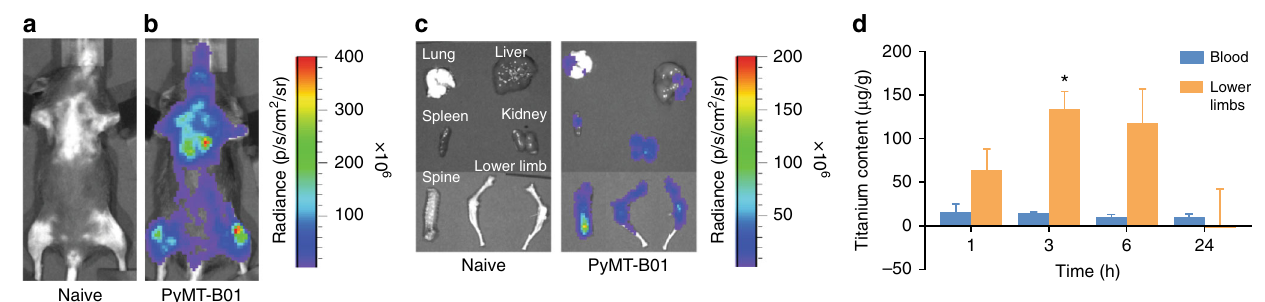
Fig. 5 Dissemination of metastatic breast cancer cells and biodistribution of TC in mice. a In vivo BLI non-tumour-bearing C57BL/6J mice. b In vivo BLI of metastatic breast cancer 10 days post intracardiac injection of PyMT-BO1 GFP/Luc in C57BL/6J mice. c Ex vivo BLI of metastatic tumour burden 10 days post tumour initiation. The left panel are tissues obtained from a mouse and the right panel are tissues obtained from b mouse. d Inductively coupled plasma mass spectrometry analysis of Ti content in blood samples and the lower limbs, where tumour burden is high. The Ti content was background- corrected from untreated mice; * P < 0.05. Studies were performed with n = 5 mice per